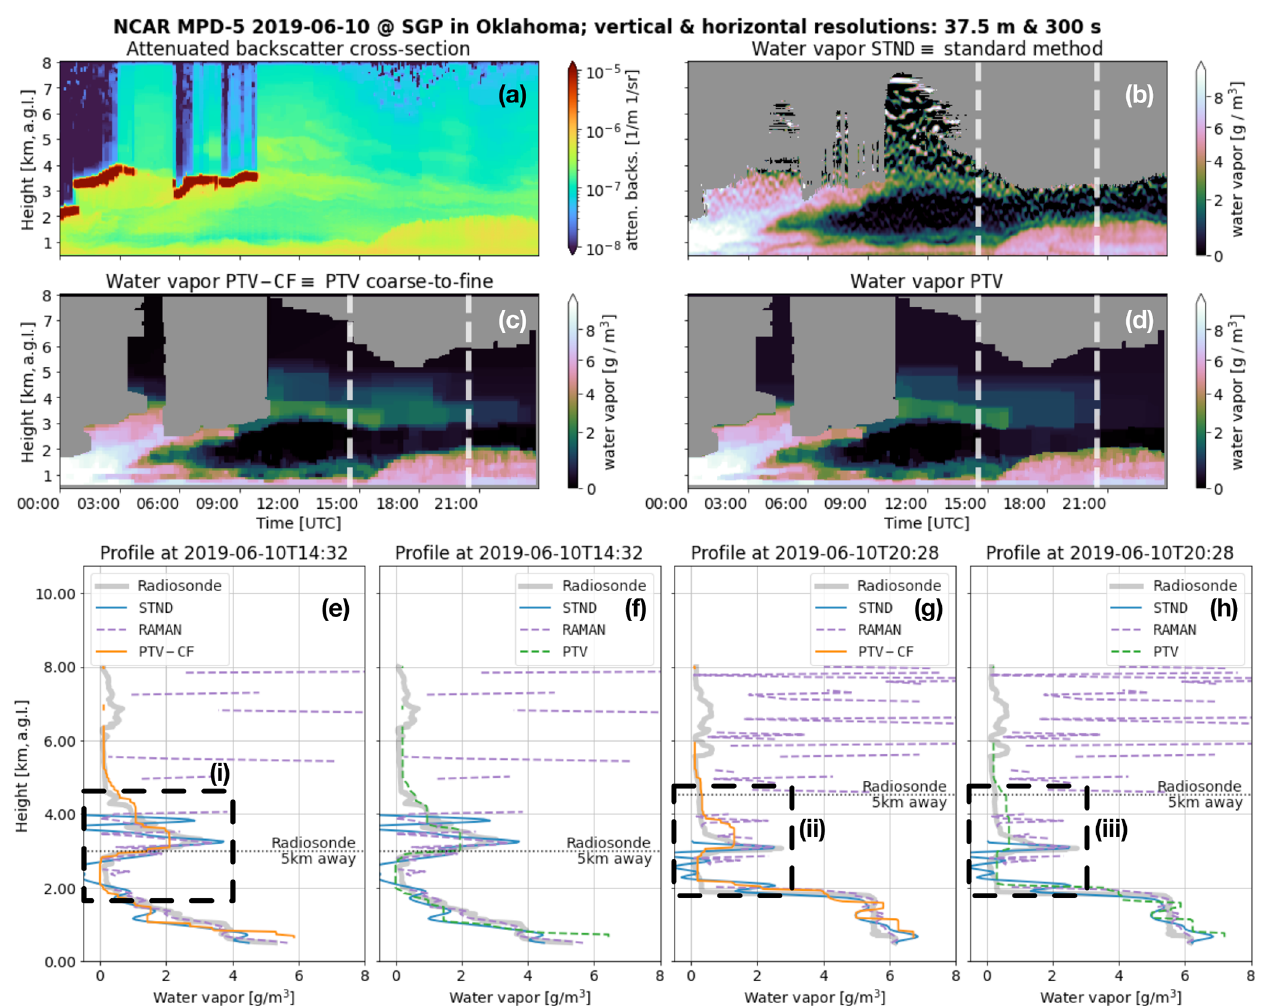
Figure 4. The (a) attenuated backscatter cross section and the water vapor (WV) measurements of the (b) standard method ( STND ) and the PTV-MPD method (c) with ( PTV-CF ) and (d) without ( PTV ) the coarse-to-fine configuration. Panel (a) is not masked to show what atmospheric features have been masked out in (b) to (d) by the gray areas. The dashed vertical white lines in (b) to (d) show the launch times of the radiosondes (RSs), where (e) to (h) show the RS and Raman lidar WV profiles. Panels (e) and (g) compare the course-to-fine PTV-MPD WV measurements against those of the RS and the standard method, whereas (f) and (h) show the same comparison for the PTV-MPD method without the course-to-fine configuration. The horizontal dashed lines in (e) to (h) show the altitude at which the RS was horizontally 5km away from the MPD. The dashed boxes in (e) and (g) highlight regions that are discussed in the text.